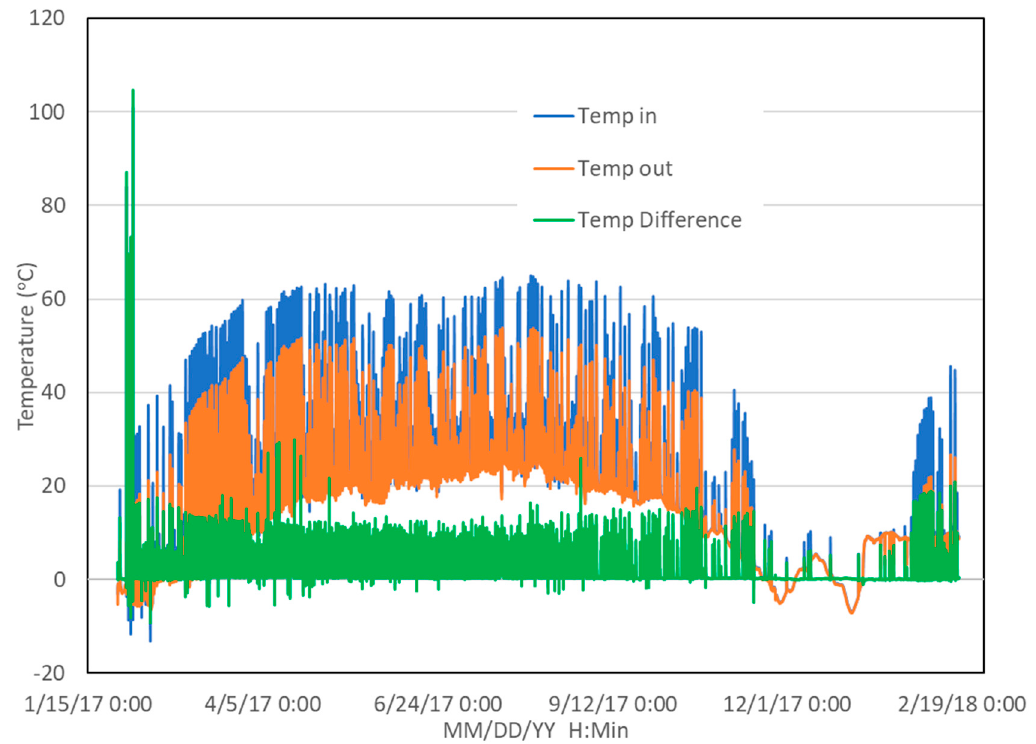
Figure 11. Glycol-water mixture supply and return temperatures.